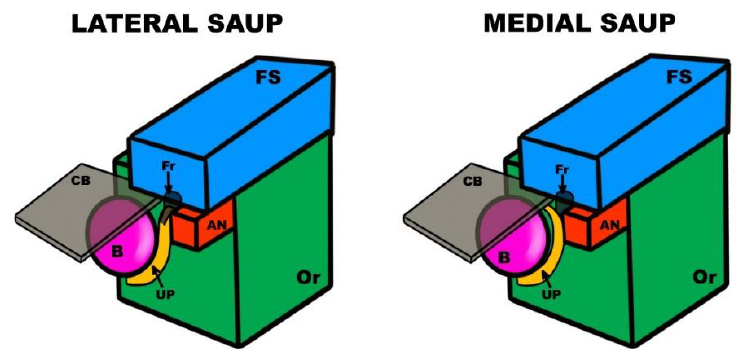
Figure 3. Schematic representation of the frontal recess (Fr). Abbreviations: Frontal sinus (FS), Agger nasi cell (AN), Orbit (Or), Cranial base (CB), Uncinate process (UP), Ethmoidal bulla (B), Lateral SAUP: representation of Type I SAUP (lamina papyracea), Medial SAUP: representation of Type V (cranial base). Note that the Fr has been simplified as a duct for an educational